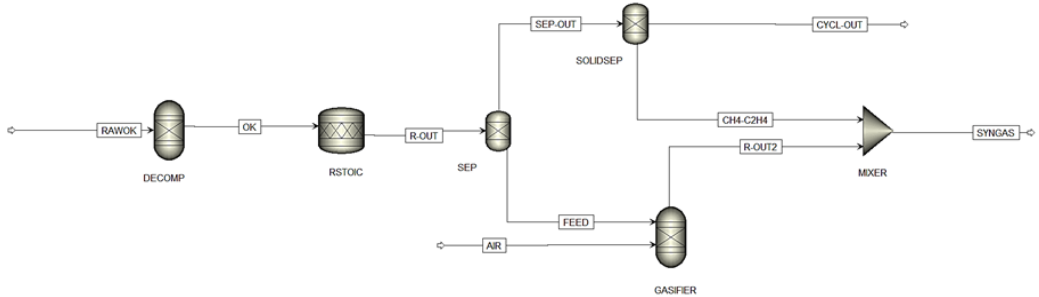
Figure 7. The flowchart used for the process simulation in Aspen Plus.